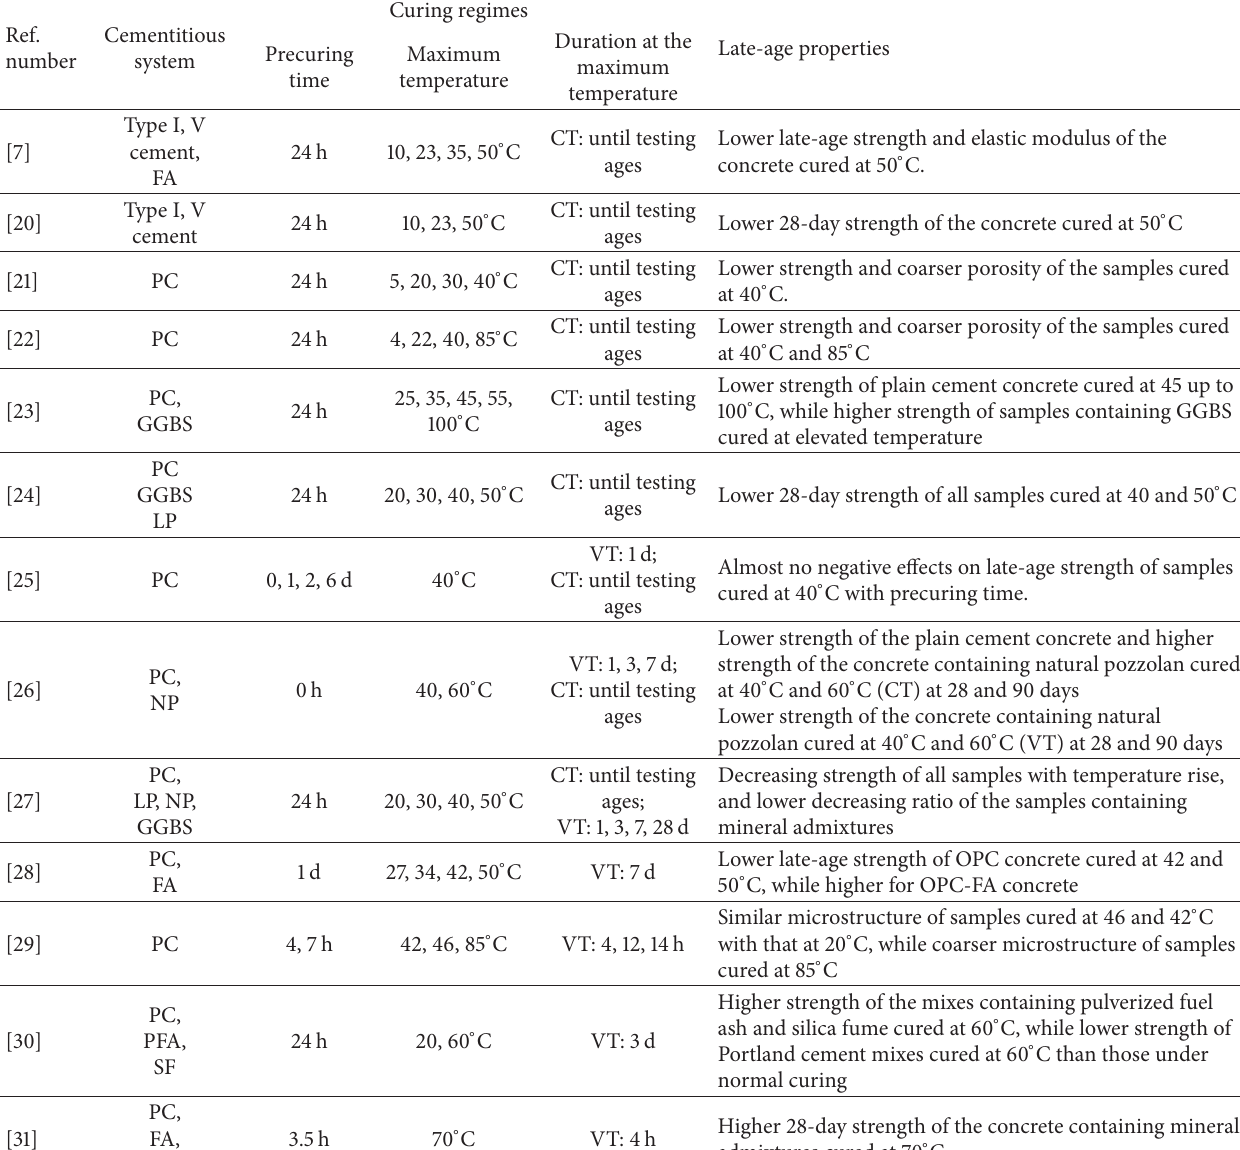
Table 1: Results of late-age properties of concrete cured at high temperature.